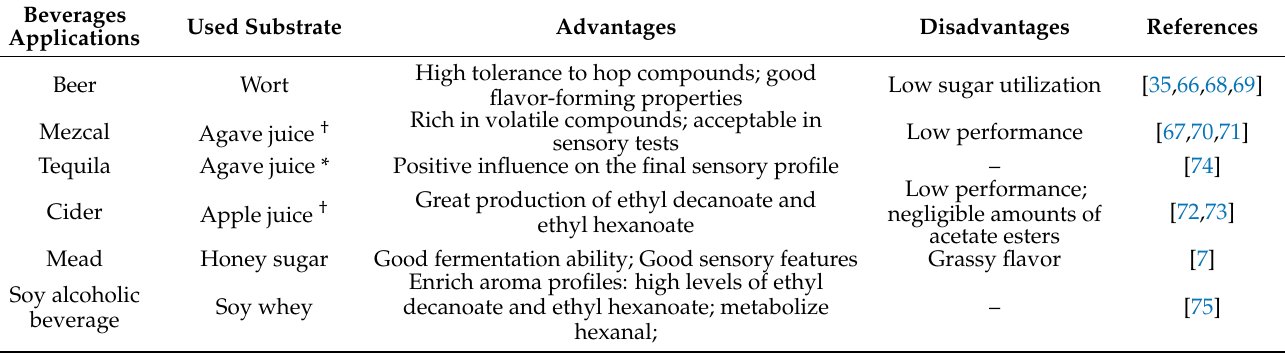
Table 2. Torulaspora delbrueckii ’s applications in fermented